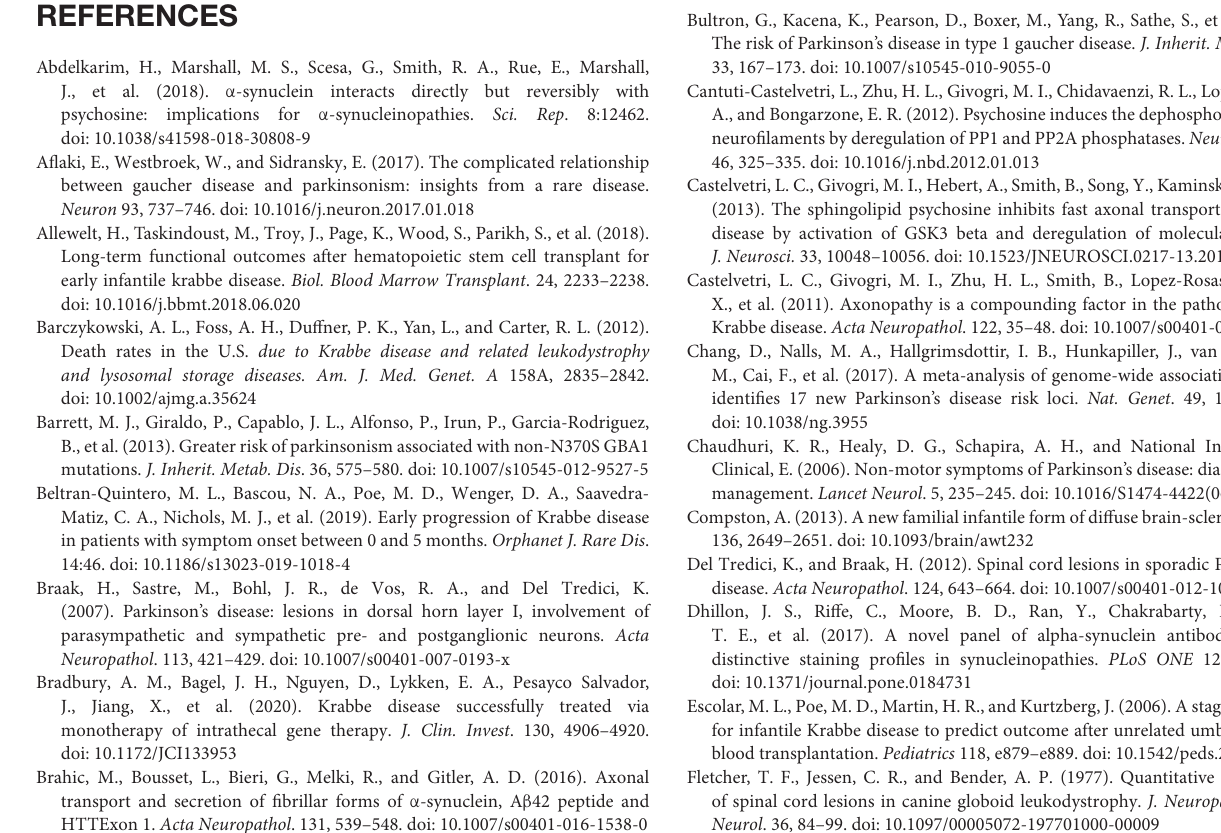
Supplementary Figure 1 | Thioflavin-S positive accumulations normalized to neuronal population. NeuN staining was used to identify neuronal cells. Number of thioflavin-S (thio-S) positive cells was normalized to the number of neuronal cells in both the lumbar and cervical spinal cord of P45 TWI. Significance between means analyzed by t -test with ( ∗ ) indicating p < 0.05 and ( ∗∗ ) p < 0.01. n = 2 animals. Results are presented as mean ± error of the mean. Supplementary Figure 2 | GALC activity and psychosine levels in spinal cord normalize after AAV-GALC gene therapy. Spinal tissues from post-natal day 40 (P40) twitcher (TWI) mice and aged WT and AAV gene therapy-treated TWI mice were analyzed for GALC activity (A) . Aged WT had a significantly higher level of GALC activity compared to P40 TWI. TWI treated with either AAV gene therapy alone or in combination with bone marrow transplantation (BMT) had a significantly higher level of GALC activity. TWI treated with BMT only did not show a significant increase in GALC activity. Tissue from the same animals was also analyzed for psychosine content (B) . P40 TWI were found to have significantly higher psychosine levels compared to aged WT and the aged AAV-treated TWI. TWI treated with BMT only had a significant decrease in psychosine levels compared to the P40 TWI but were still significant elevated compared to aged WT. Significance between means analyzed by ANOVA and Tukey’s post-hoc analysis with ( ∗∗∗∗ ) indicating p < 0.0001. n = 3 animals for all groups except aged TWI-AAV which n = 2. Results are presented as mean ± error of the